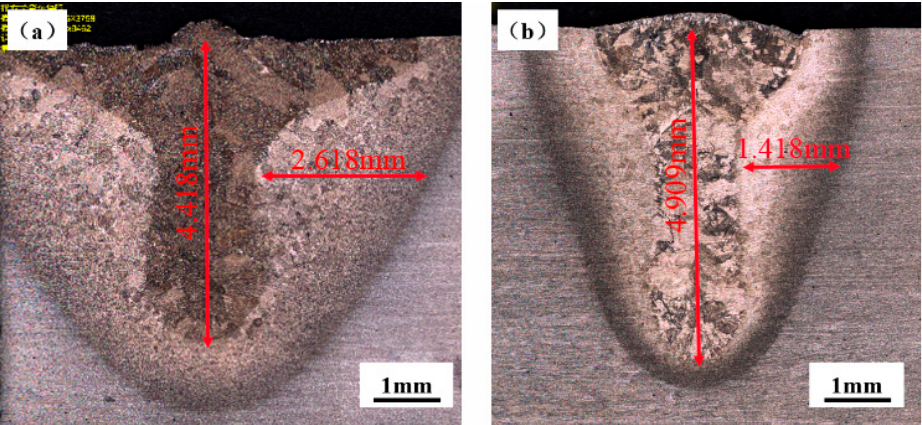
Figure 6. Cross section of air and underwater welds: ( a ) welding in air; ( b ) underwater